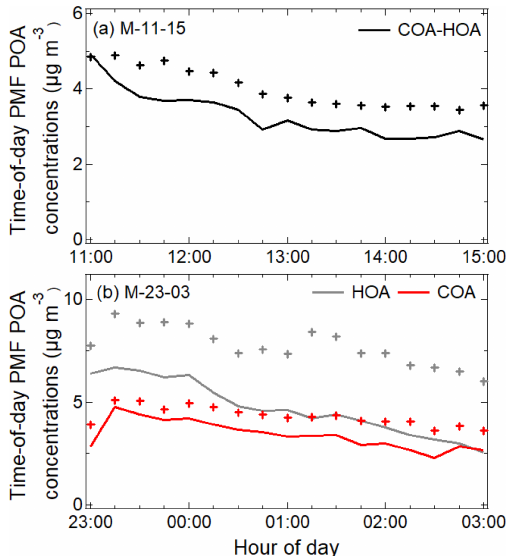
Figure 5. The 15min averaged seasonally representative diurnal Figure 4. The 15min averaged seasonally representative mean ( + ) mean ( + ) and median (lines) concentration time series of POA for and median concentrations (lines) of time-of-day PMF primary fac- the periods: (a) W-11-15 and (b) W-23-03 (in µgm − 3 ) . Nighttime tors for the periods (a) M-11-15 and (b) M-23-03 (in µgm − 3 ) . factors show evidence of Nighttime HOA shows stronger episodes than COA. Table 3. Time series correlations of time-of-day POA and OOA TS with seasonal POA and OOA TS. Slope/intercept with the corresponding seasonal Period